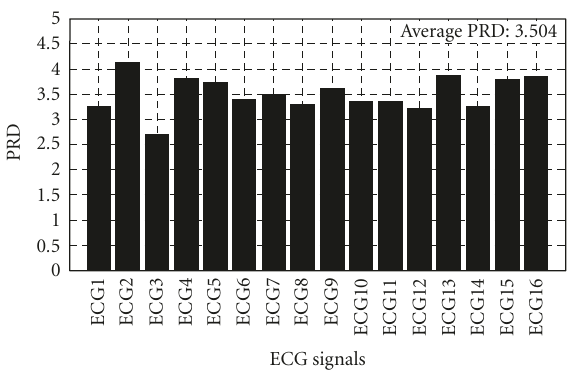
Figure 7: PRD values associated with ECG signals in the ECGMAN database for L F =